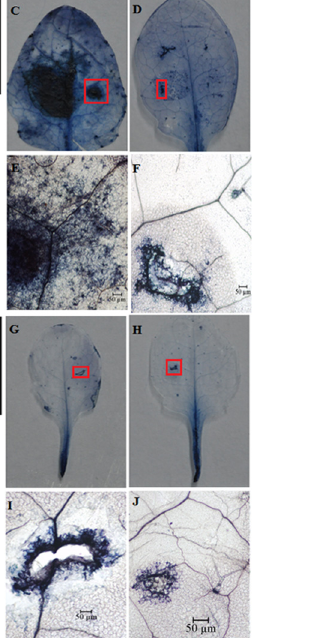
Fig 7. Transgenic expression of CkPGIP1 increases resistance to Botrytis cinerea and Rhizoctonia solani in Arabidopsis. A-B. Disease symptoms (top panel) and lesions (bottom panel) 6 d after wild type and transgenic Arabidopsis were inoculated with B . cinerea ( A ), and 5 d after inoculation with R . solani ( B ). Error bars are standard error (n = 3). * , P < 0.05 and ** , P < 0.01 by least significant difference against wild type. C - D. Trypan blue staining of wild type (C) and transgenic Arabidopsis leaves (D) 4 d after inoculation with B . cinerea . E-F. Zoomed-in view of disease symptoms boxed in red in (C) and (D) . G - J. Trypan blue staining of wild-type (G) and transgenic Arabidopsis leaves (H) at 3 d post-inoculation with R . solani . ( H ) and ( I ) are enlarged views of areas boxed in red in ( G ) and ( H